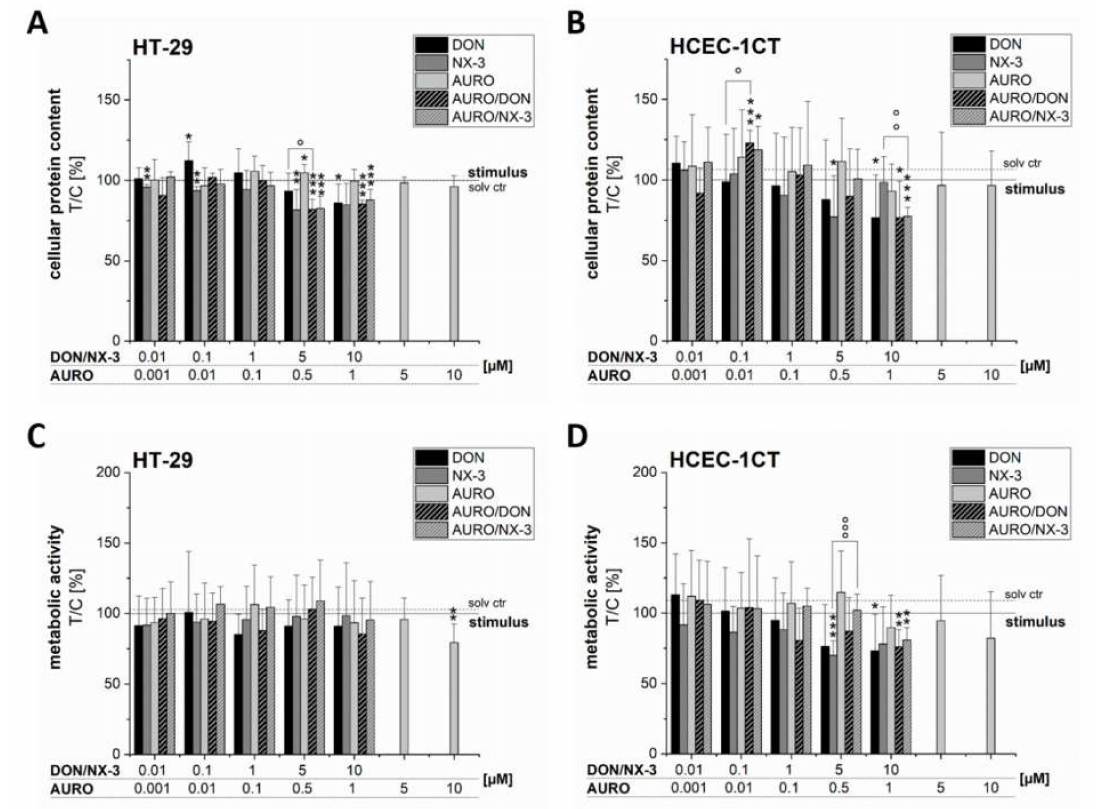
Figure 5. E ff ects of DON, NX-3, AURO and their combinations on the cellular protein content ( A,B ) and viability ( C,D ) of the two human colon cell lines HT-29 and HCEC-1CT determined in the sulforhodamine B (HT-29: A ; HCEC-1CT: B ) and alamarBlue ® assay (HT-29: C ; HCEC-1CT: D ). Cells were preincubated with the compounds (DON, NX-3, AURO and their combinations) for 2 h followed by a 3 h IL-1 β challenge (25 ng / mL). Data are expressed as mean values ± SD normalized to IL-1 β -treated solvent control samples of at least five independent experiments. One percent DMSO and 1% water (LC–MS grade) served as solvent control (dotted line). Significant di ff erences to IL-1 β -treated solvent control, calculated with one-sample t -test, are indicated with * ( p < 0.05), ** ( p < 0.01) and *** ( p < 0.001), whereas di ff erences between DON, NX-3 and their combinations with AURO, calculated with a two-sample t -test, are indicated with ◦ ( p < 0.05), ◦◦ ( p < 0.01) and ◦◦◦ ( p <